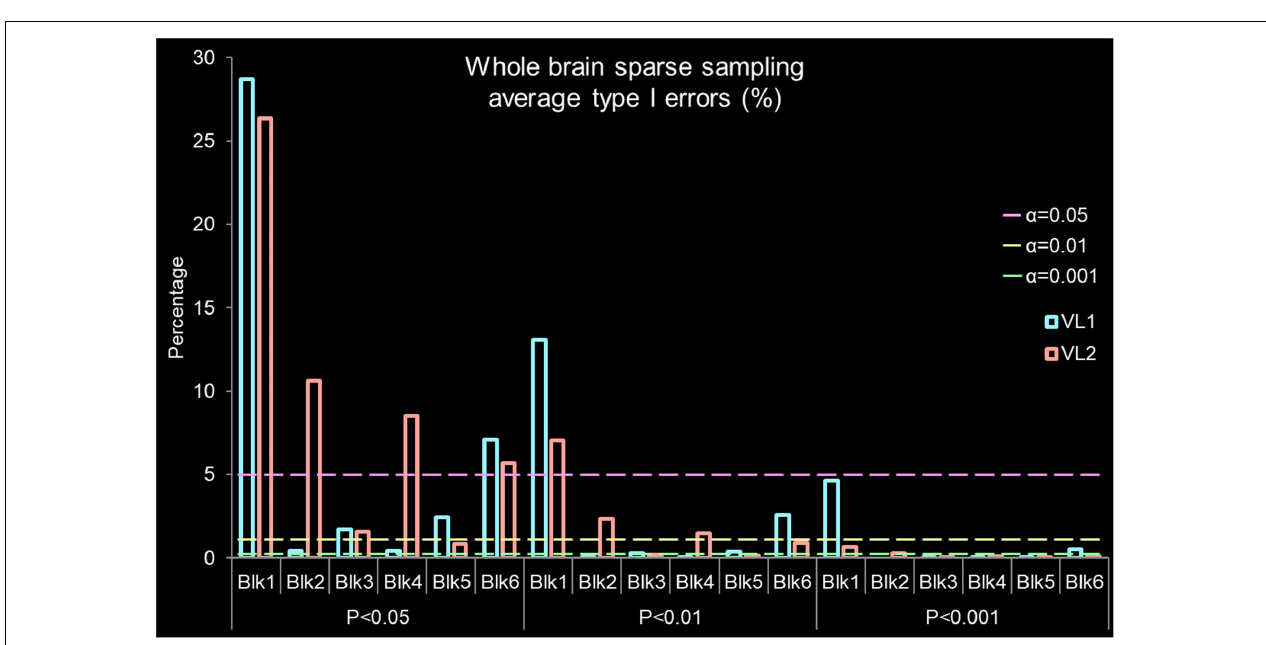
FIGURE 2 | Whole brain sparse sampling of silence, derived BOLD signal average and range. A sparse sampling paradigm was conducted and whole brain activation/deactivation maps were derived for t -value difference from the auditory evoked paradigm ( Figures 1a,b ). (a) The entire brain activation/deactivation t- values were mapped (unthresholded) for each block (column) by the first volume (VL1) or second volume (VL2). The color bar denotes the t -value range for the paradigm. Here, the t -values were taken to derive type I errors. (b) The table represents average ± standard deviation and maximum to minimum t- values for the entire acquired volume.